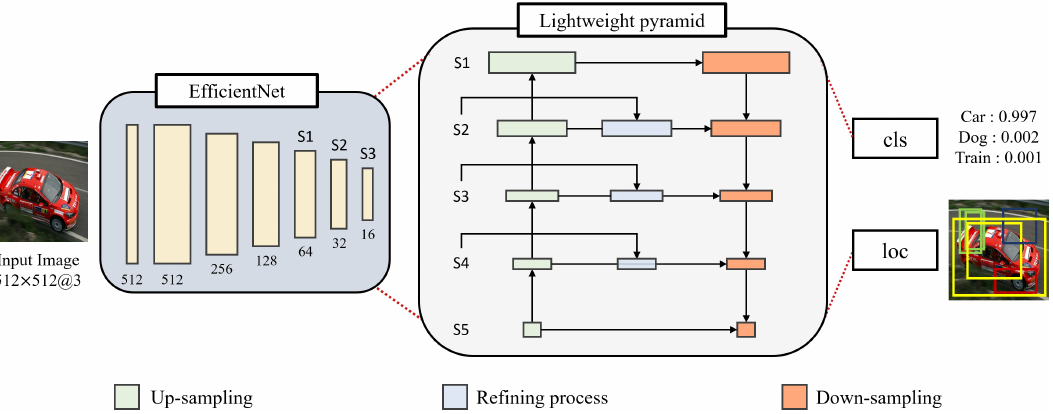
Figure 2. Efficient Shot Detector (ESDet)